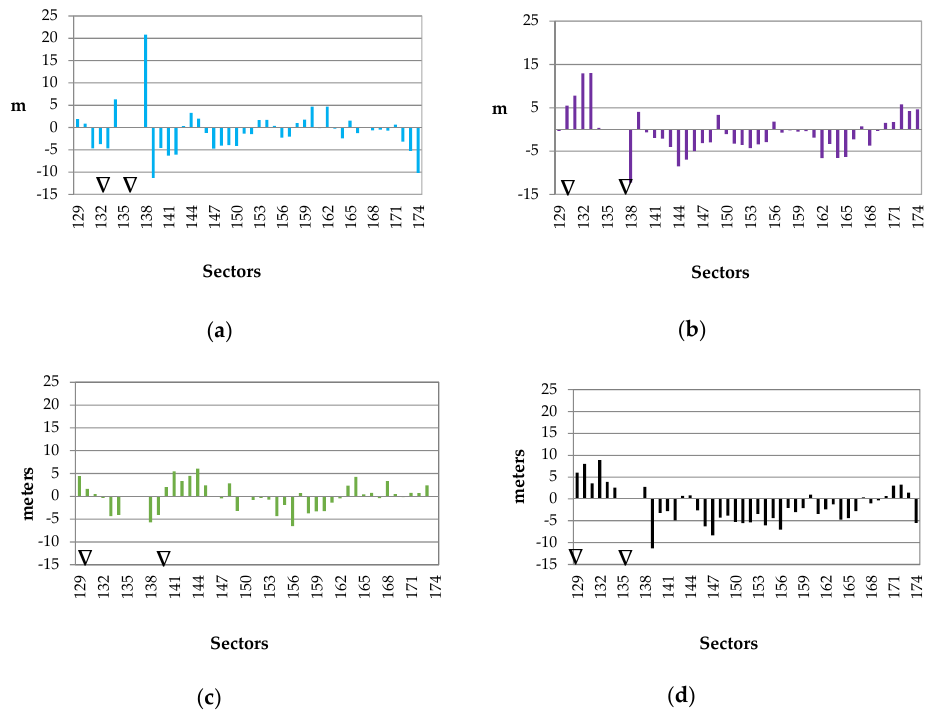
Figure 9. Shoreline displacement at San Vincenzo test site in the timeframes (a) 2005–2010, (b) 2010–2014, (c) 2014–2018, (d) 2018–2005. Sectors from 135 to 137 belong to the harbor area; the nabla symbol indicates artificial nourishments or hard works affecting the displacement rates.